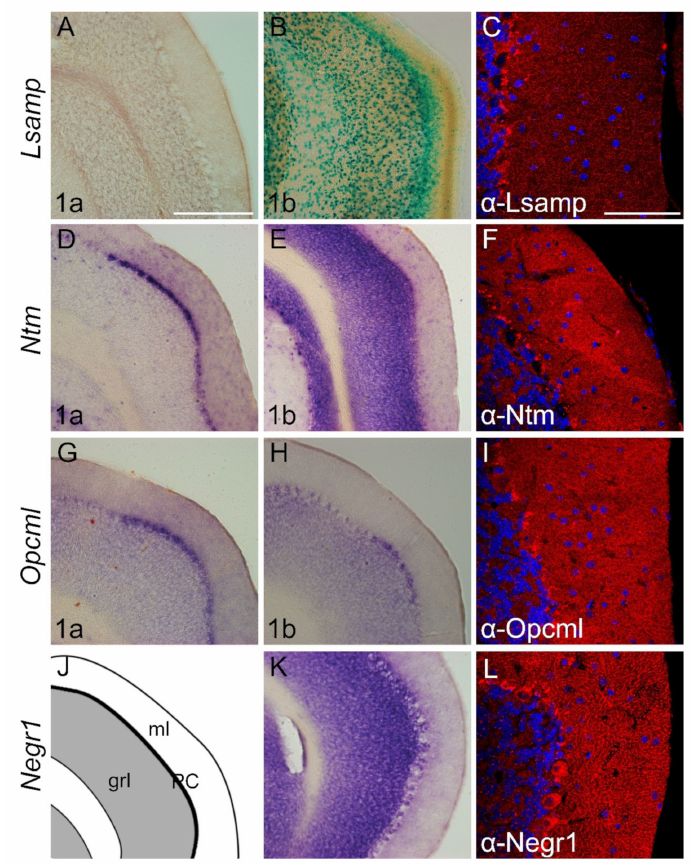
Figure 7. Expression from IgLON alternative promoters and proteins in adult mouse cerebellum. ( A , D – E , G , H , K ) in situ mRNA hybridization; ( B ) X-gal staining; ( C , F , I , L ) immunofluorescence